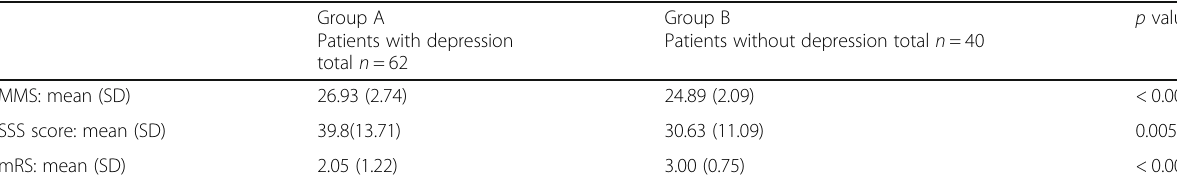
Table 3 Different applied scales in both groups